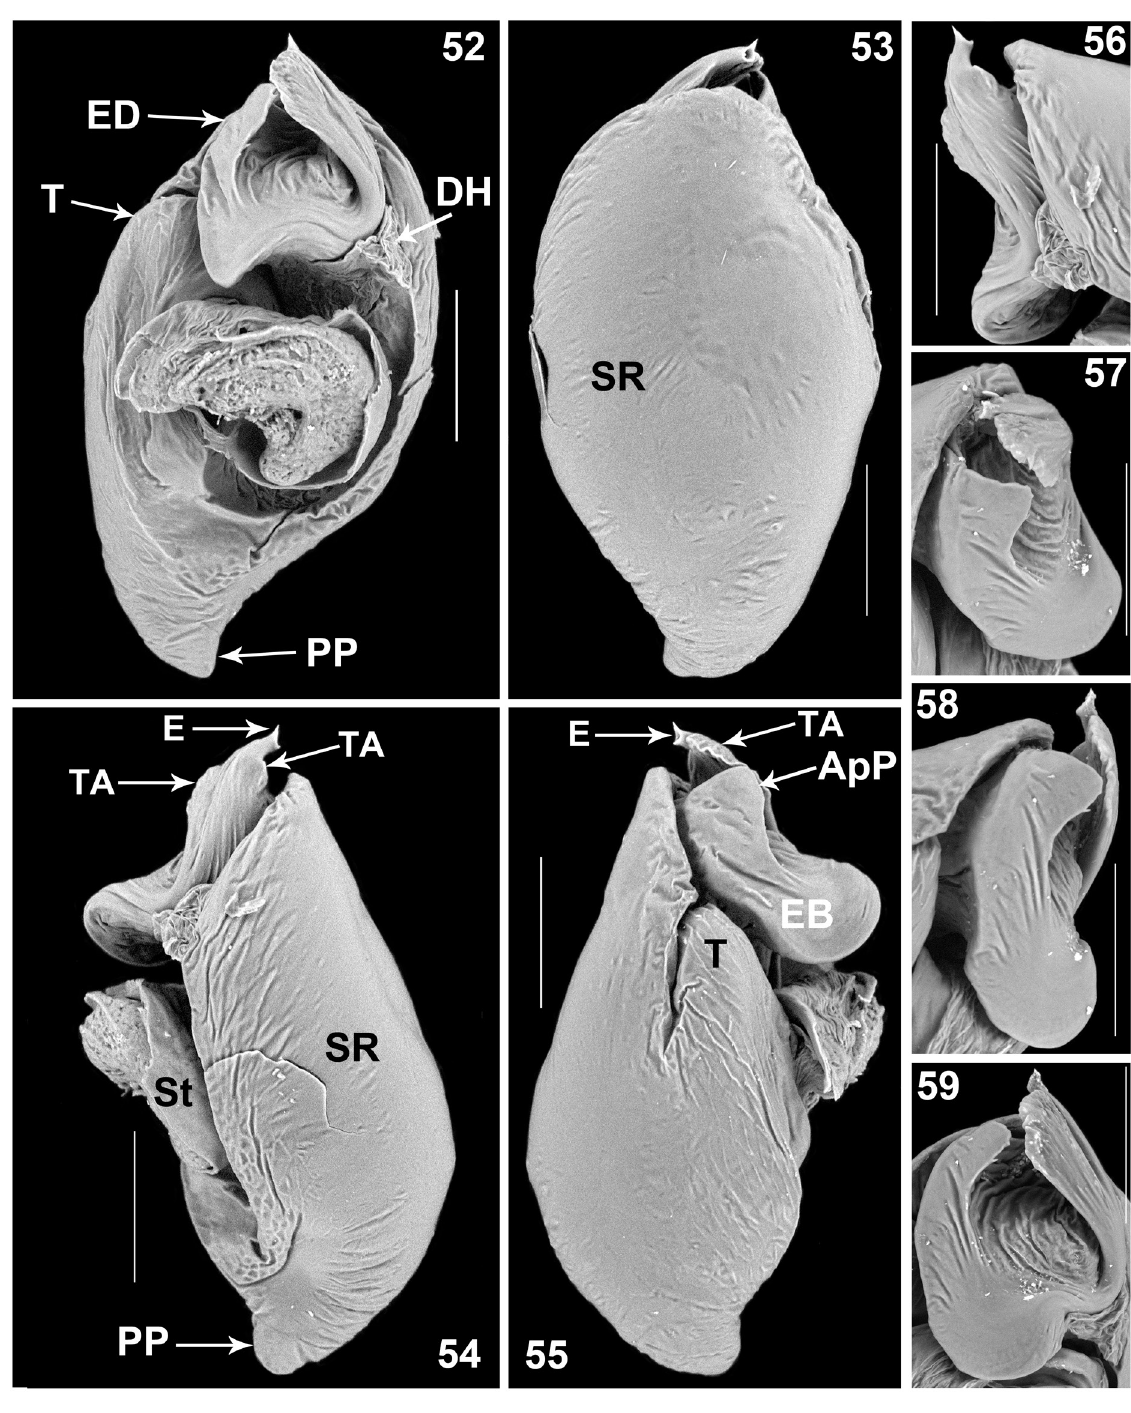
Figs 52–59. Manzuma jocquei (Azarkina, Wesołowska & Russell-Smith, 2011) gen. et comb. nov., from Côte d’Ivoire (Gagnoa), scanning electron micrographs. 52–55 . Male bulbus. 52 . Dorsal view. 53 . Ventral view. 54 . Prolateral view. 55 . Retrolateral view. 56–59 . Embolic division. 56 . Prolateral view. 57 . Retrolatero-apical view. 58 . Retrolateral view. 59 . Dorsal view. Scale bars: 0.1